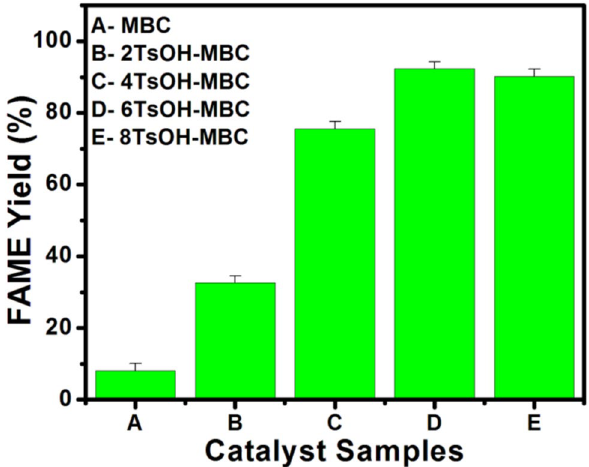
Figure 1. FAME content against the various catalyst samples used.